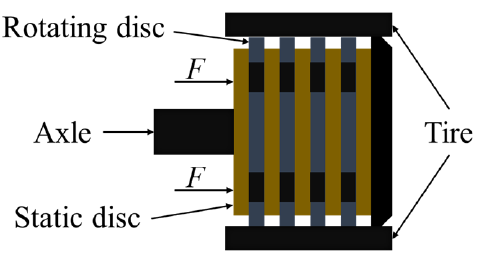
7 of 16 ω and the brake pressure F , and then it outputs the corresponding friction coefficient of the brake disc b μ to the brake apparatus. Figure 5. Brake control principle.